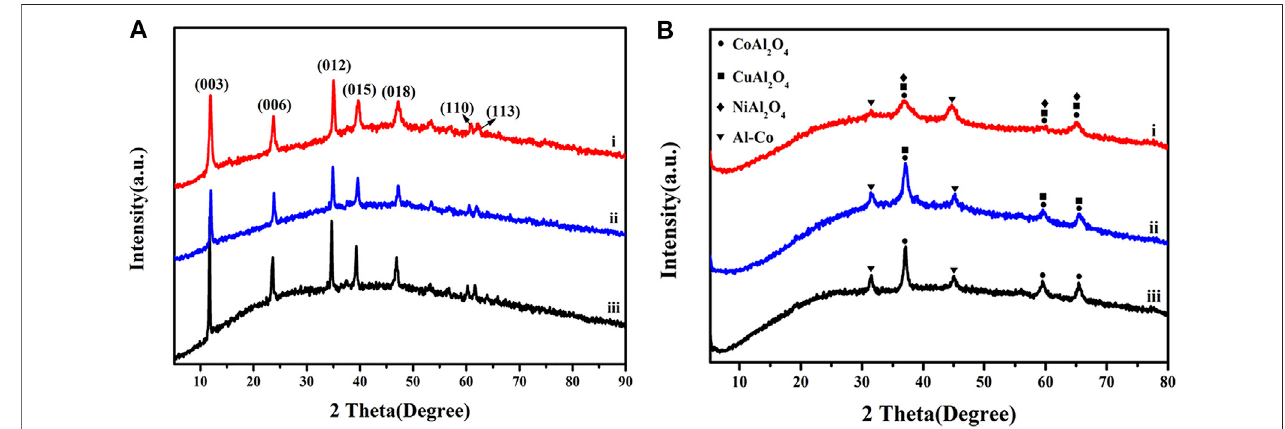
FIGURE 4 | XRD patterns for (A) CuCoNiAl-LDH (i) , CuCoAl-LDH (ii) and CoAl-LDH (iii) , and (B) CuCoNiAl-MMO (I) , CuCoAl-MMO (ii) and CoAl-MMO (iii)